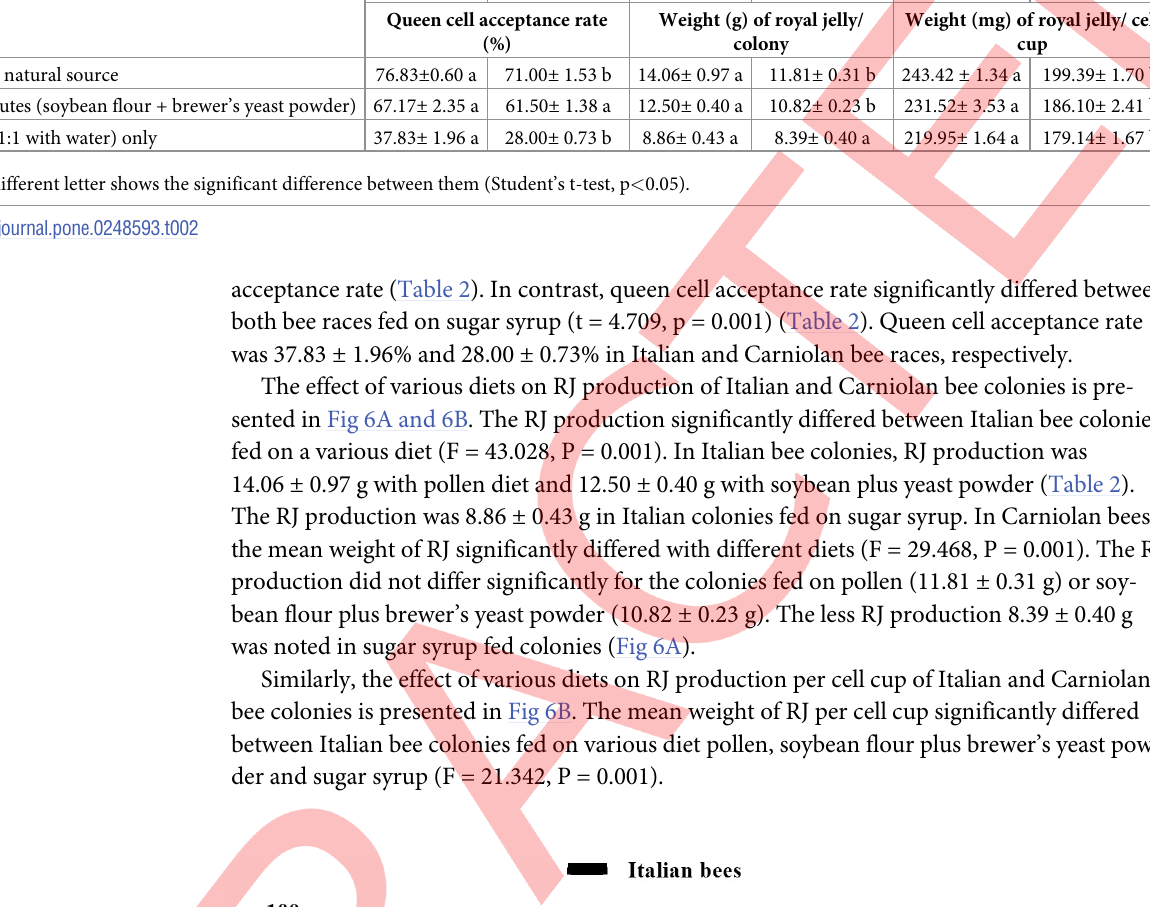
Table 2. The effect of various diets on the queen cell acceptance rate and royal jelly production between Italian and Carniolan bee colonies. Treatment